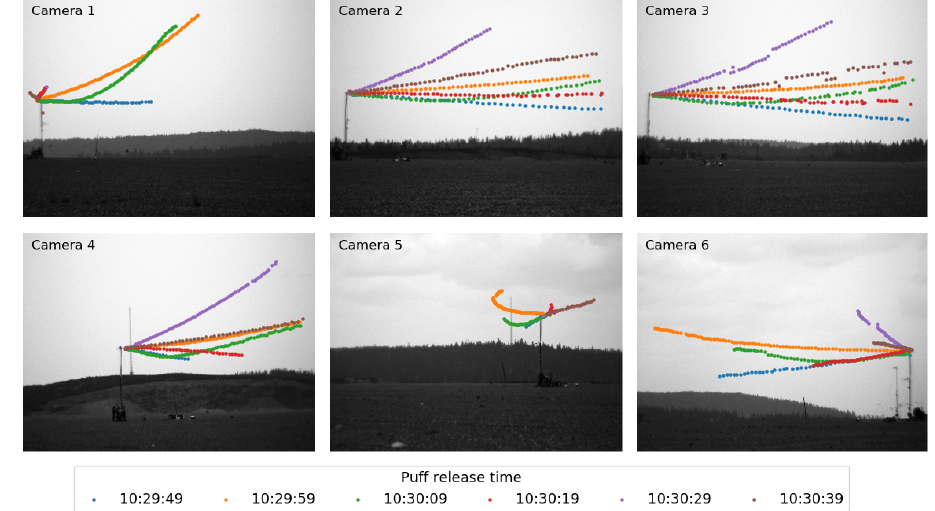
Figure 7. Centre of mass coordinates of six subsequent puffs projected to the image planes of the six SO 2 cameras. For cameras 4 and 5, a meteorological tower is visible in the image background. This tower is located a few hundred metres northwest of the release tower.